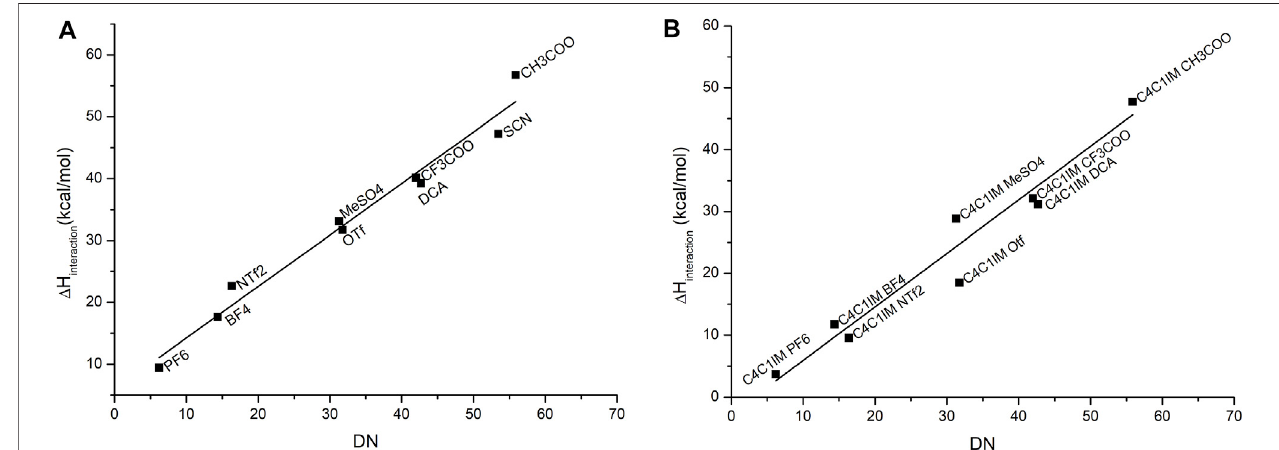
FIGURE 3 | Correlation between the experimental DN values and the calculated binding enthalpies between antimony pentachloride and (A) the corresponding anion, where the equation that fi ts this correlation is y (cid:1) 0 , 83 DN + 5 , 89 with a correlation coef fi cient R 2 (cid:1) 0 , 968, and (B) ionic liquid. The equation that fi ts this correlation is y (cid:1) 0 , 86 DN − 2 , 70 with an adjusted R-square value of R 2 (cid:1) 0 , 937. The IL C 4 C 1 IMSCN was excluded due to problems of convergence.